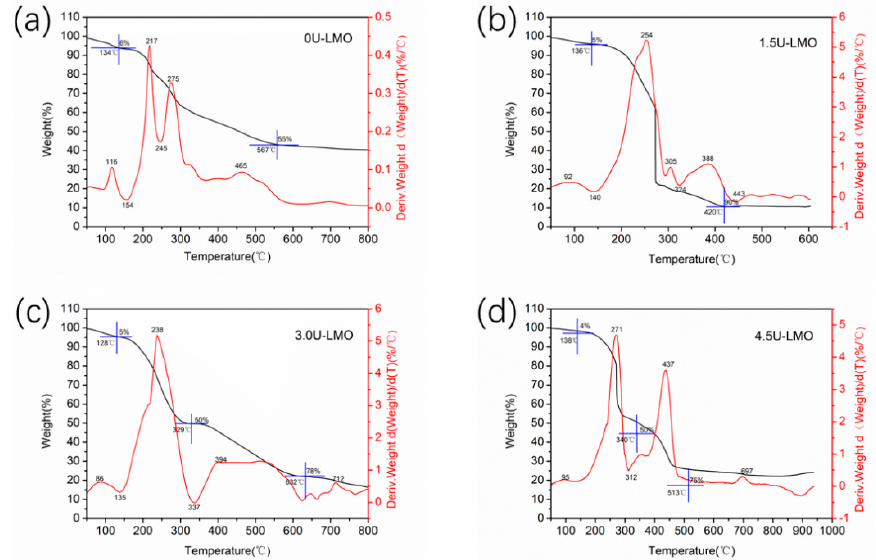
Figure 1. TGA/DTA curves of as-prepared ( a ) 0U-LMO, ( b ) 1.5U-LMO, ( c ) 3.0U-LMO, and ( d ) 4.5U- LMO precursors.